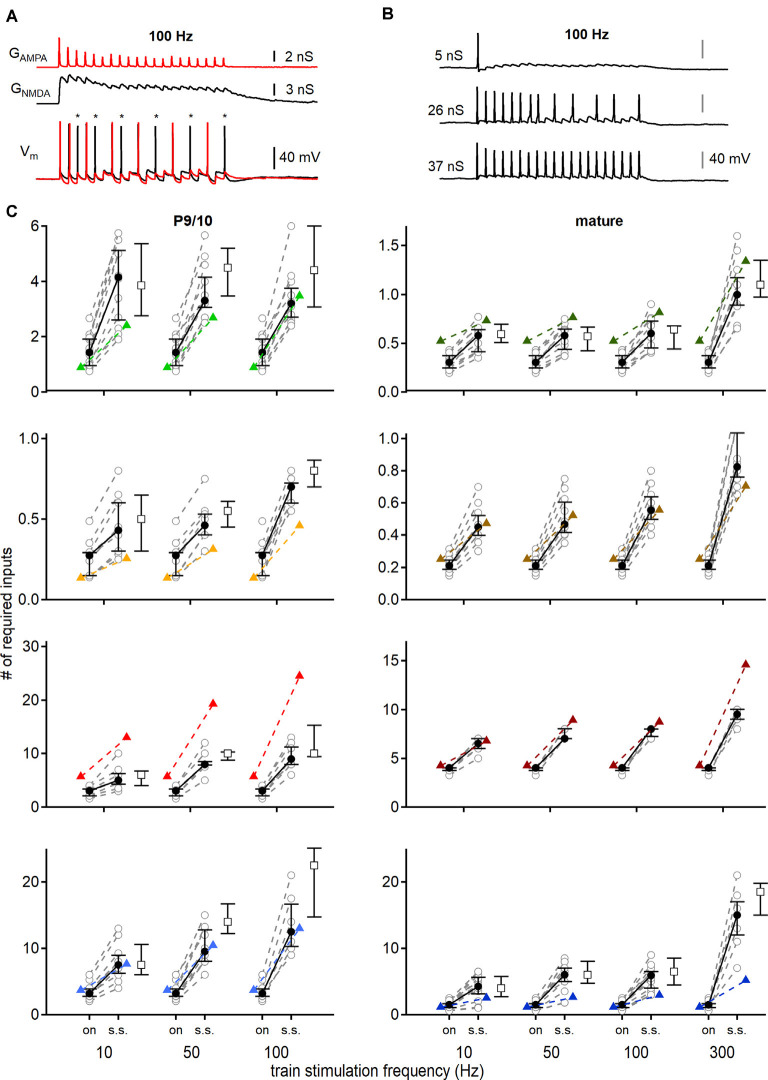
Conductance based input-output functions to estimate the minimal input requirement for action potential generation. (A) Stimulation with AMPAR (red) and NMDAR (black) conductance templates (top) and recorded voltage responses (bottom). The addition of NMDAR conductance generated more action potentials (black trace). Red voltage response was evoked by only AMPA EPSGs. Asterisks show additional action potentials when both conductances (AMPAR and NMDAR) were applied. (B) Voltage responses of a P69 DNLL neuron to 100 Hz EPSG trains. Scaling the template amplitude to extract the conductance threshold for single action potential generation (top) until all pulses within the train stimulation produced action potentials (bottom). nS values refer to the peak conductance of the first pulse. (C) Number of minimally required inputs of P9/10 (left) and mature (right) VNLL, MNTB, MSO, and DNLL neurons for single onset (left symbols, on) and continuous steady-state (right symbols, s.s.) action potential generation, according to firing frequency (10, 50 and 100 Hz, and 300 Hz for mature neurons). Predictions of Figure 5 displayed as colored triangles. Open squares show input requirements by removing the NMDAR conductance. Number of recorded neurons for VNLL: y; n = 12, m; n = 11, MNTB: y; n = 9, m; n = 10, MSO: y; n = 8, m; n = 7, DNLL: y; n = 10, m; n = 13. Data are shown as median and first and third quartiles. Nuclei color-coded as in Figure 2.